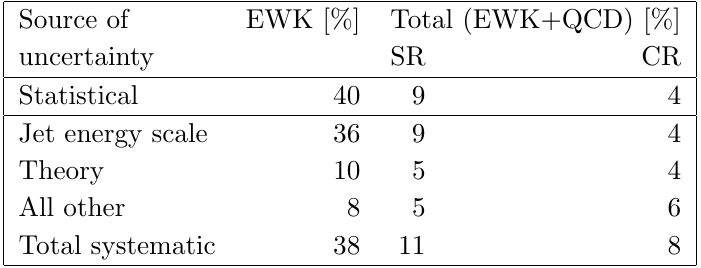
Table 6 . Summary of the main relative uncertainties in cross-section measurements presented in this